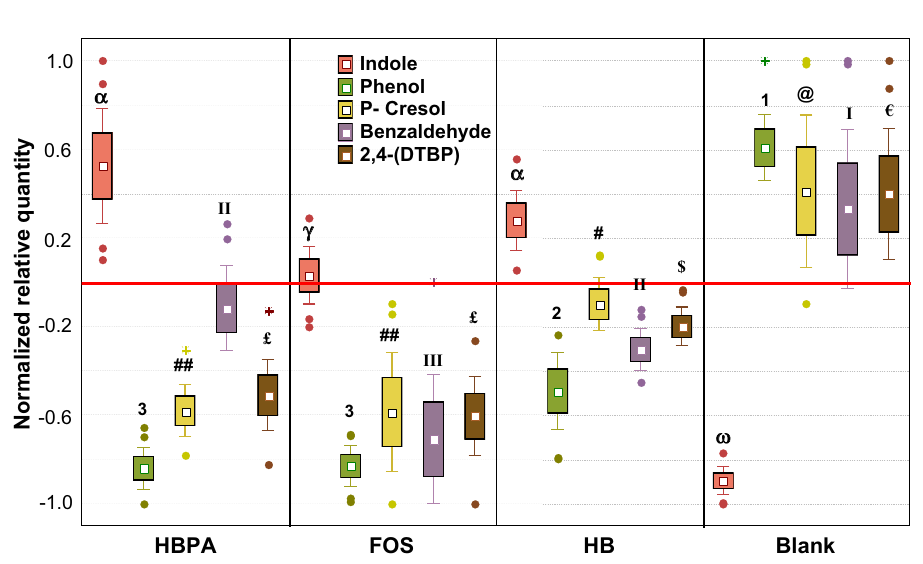
Figure 3. Changes in the abundance of detrimental microbial VOCs metabolites, expressed as normalized scale from relative abundances with respect to the baseline (red line). The baseline absolute quantifications in mg/kg are found in the Supplementary Material (Table S3). Changes were recorded after 6, 18, and 24 h of in vitro fecal batch fermentations with HBPA, HB, FOS, and a blank control. Each plot is made with the raw data obtained from each time point and replica. Samples were analyzed in duplicate from two independent experiments ( n = 4). Marker = mean; box = mean ± S.D.; whiskers = non outlier range; dots = outliers; asterisks = extremes. Cases with different letters or numbers or symbols among a single independent variable are significantly different according to Tukey’s HSD test ( p < 0.05). HB Hempseed bran; HBPA HB protein extract hydrolyzed by alcalase; FOS fructooligosaccharides; Blank Blank